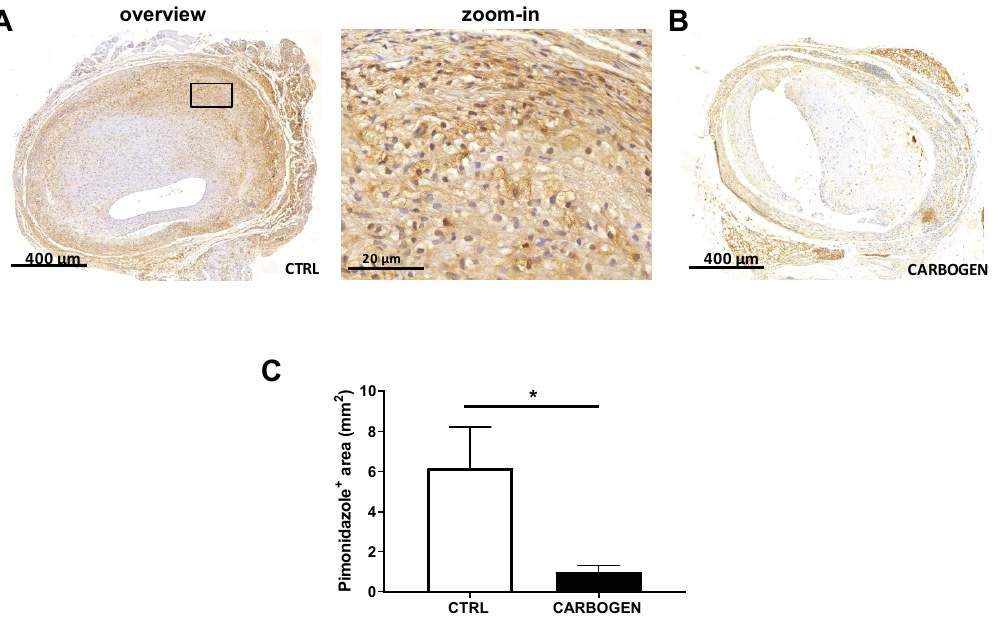
Figure 1. Short term carbogen exposure drastically reduces intraplaque hypoxia. ( A ) Representative pictures of sections from vein graft lesions in ApoE3* Leiden mice stained for pimonidazole in the control group ( n = 8) and ( B ) one-time carbogen treated group ( n = 8). ( C ) Quantification of pimonidazole positive area. Data are presented as mean ± SEM. * p < 0.05; by two-sided Student’s t test.